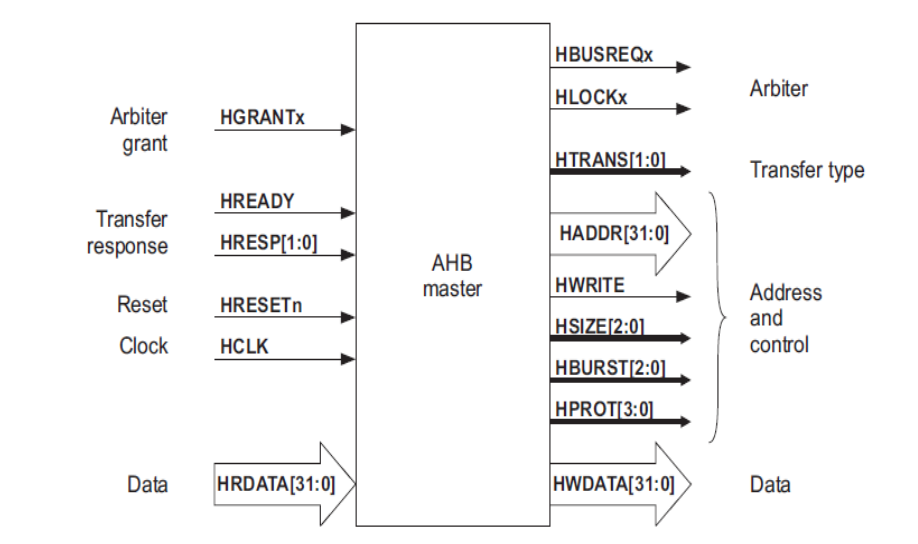
Fig. 4. AHB Bus Master Interface (AMBA™., 1999).